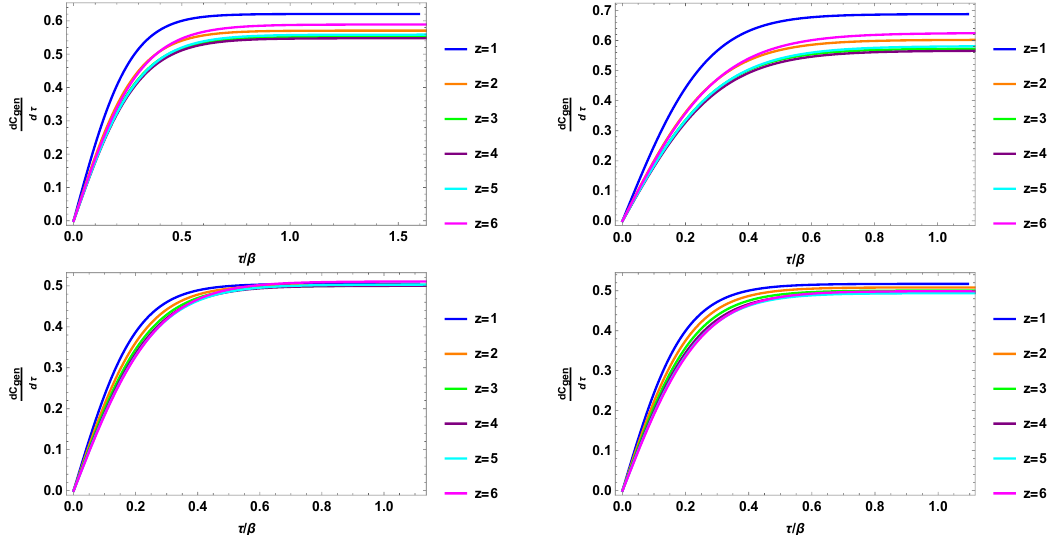
as a function of τ/β for λ 6 = 0 and different values of d , θ Figure 12 . The growth rate d C gen dτ and z : Top Left ) d = 2 , θ = 1 and λ = 10 − 4 . Top Right ) d = 3 , θ = 2 and λ = 10 − 4 . Down Left ) d = 4 and θ = 0 and λ = 10 − 5 . Down Right ) d = 5 and θ = − 1 and λ = 10 − 5 . We set L = r h = r F = G N = V d = 1 .